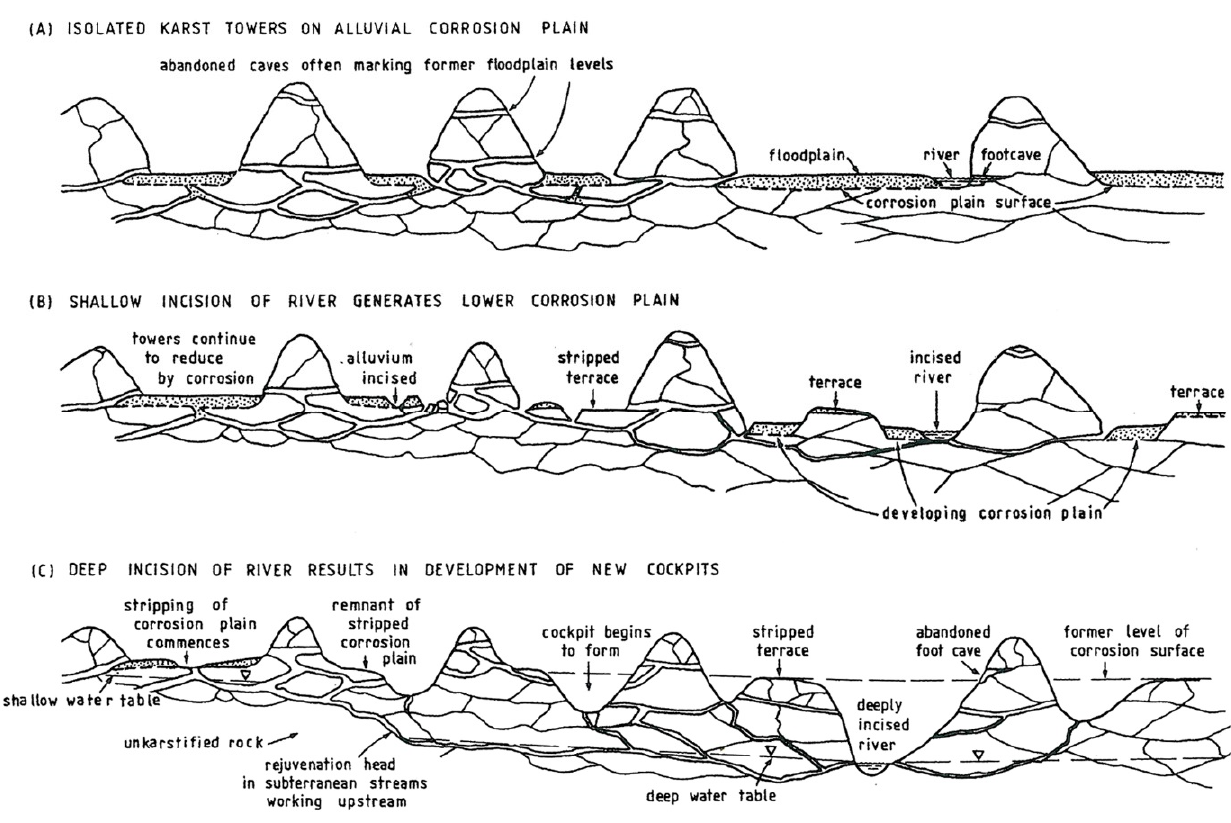
Figure 8. Irreversible transformation on tropical karst [19]. ( A ) (isolated karst towers on alluvial corrosion plain, ( B ) Shallow incision of river generates lower corrosion plain, ( C ) Deep incision of river results in development of new fengcong. Note that in ( C ) the isolated hills of the previous phase may become the tops of the highest tier of cones in the modern phase.